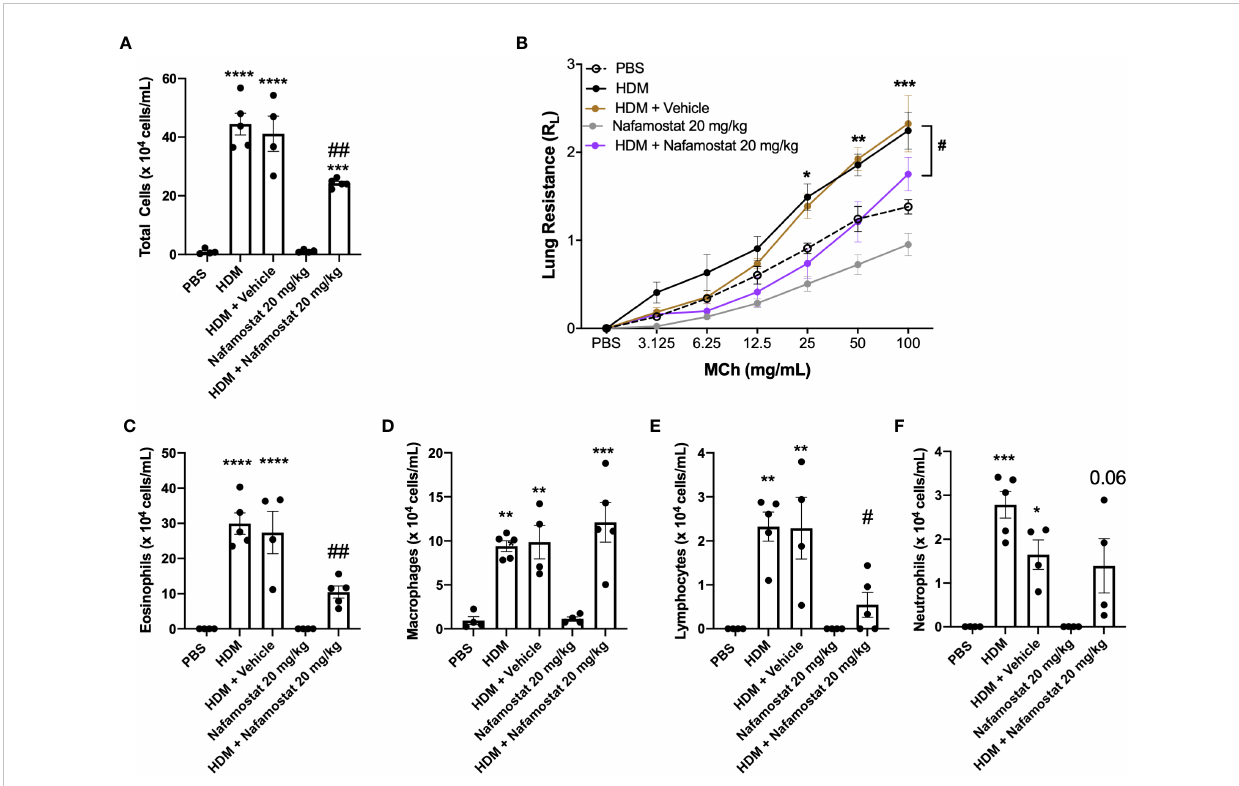
FIGURE 1 Nafamostat inhibits airway in fl ammation and AHR in HDM-induced experimental asthma. Mice received either PBS or HDM twice a week for 6 weeks. Mice were treated with vehicle or with nafamostat (20 mg/kg) 30 min prior to each HDM extract instillation. Control mice were treated with PBS only. Total cells (A) , eosinophils (C) , macrophages (D) , lymphocytes (E) and neutrophils (F) were measured in the BAL fl uid. Lung resistance (R L ) (B) was measured using a Buxco FinePointe series instrument. Data represent mean values ± SEM. * P < 0.05, ** P < 0.01, *** P < 0.001 and **** P < 0.0001 vs. the PBS group. # P < 0.05 and ## P <.01 vs. the HDM group. n = 4 – 5 mice per group. HDM, house dust